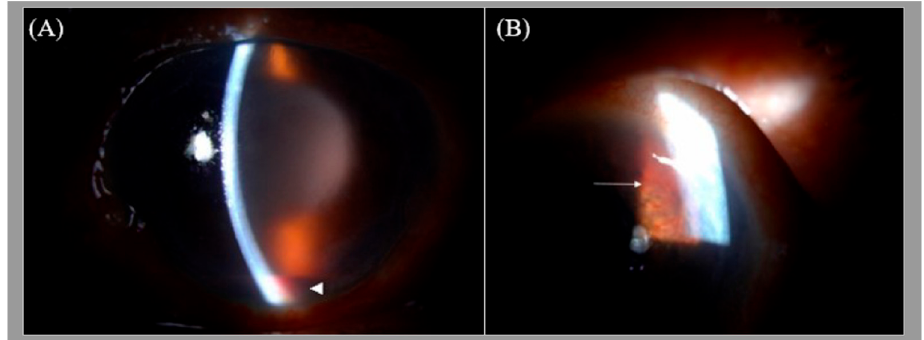
Figure 1. ( A ) The slit lamp image of the left eye showing microcystic edema in the cornea and hyphema. ( B ) Iris neovascularization (white arrow). The hazy view is secondary to microcystic corneal edema associated with increased intraocular pressure in this case of neovascular glaucoma.